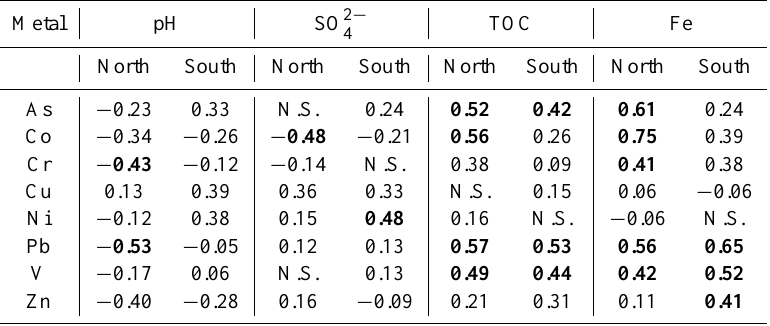
Table 5. Kendall’s τ coefficients for relationships between in-stream chemical parameters and trace metals, by region. Non-significant ( p ≤ 0 . 001) relationships are denoted by N.S. and strong relationships ( > 0 . 4) are bold. Metal pH SO 2 − TOC Fe 4 North South North South North South As − 0.23